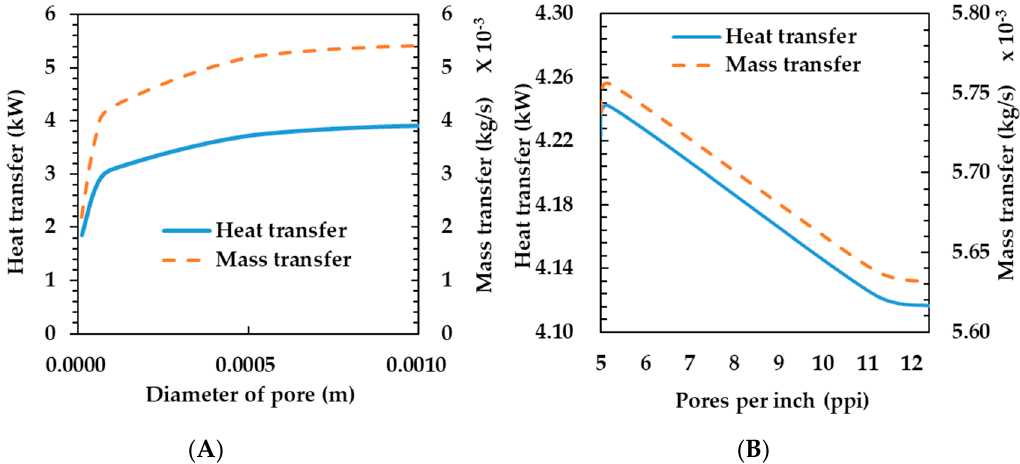
Figure 6. E ff ects of pore diameter ( A ) and compressibility ( B ) on heat and mass transfer rates of the porous metal foam humidifier.